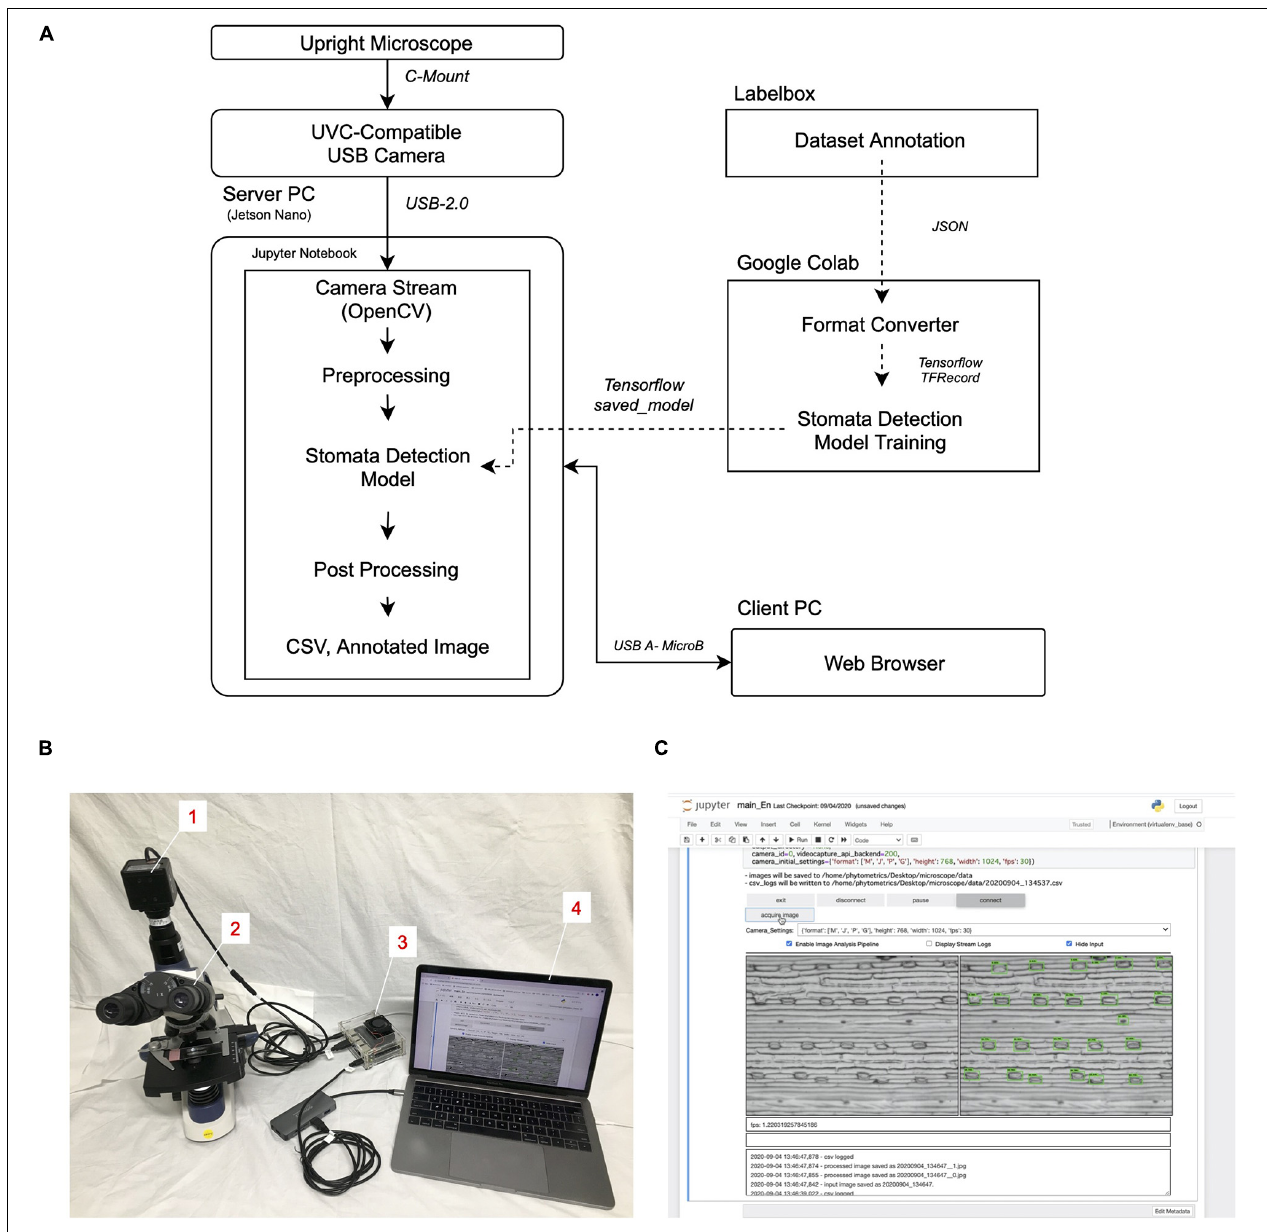
FIGURE 1 | Stomatal detection platform. (A) Schematic diagram of the workflow. (B) Appearance of the platform. Numbers in insets describe the individual components. 1, UVC-compatible camera (ELP-USB13M02-MFV); 2, upright trinocular microscope (SW380T); 3, server PC (Jetson Nano B01); 4, client PC (Macbook Pro 13-inch, 2017). (C) Screenshot of the GUI run in the client PC through the Google Chrome web browser.